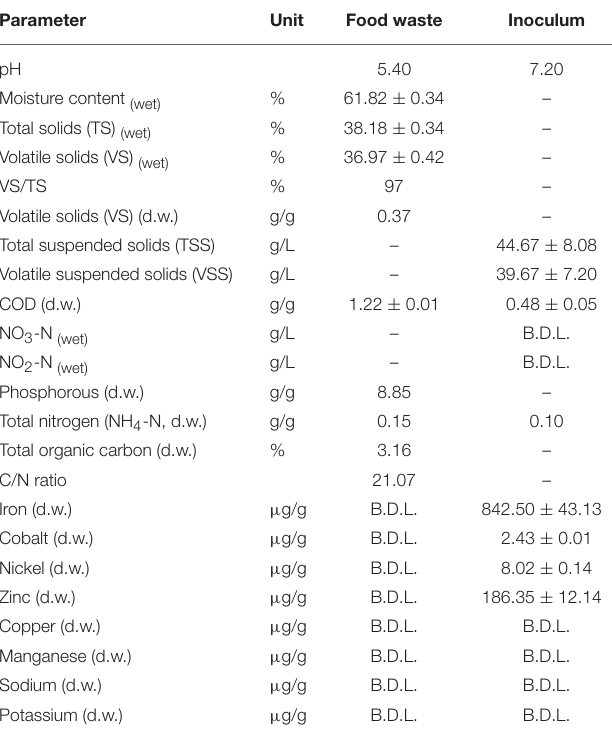
TABLE 2 | Characteristics of the mixed food waste and the inoculum used for the AD process.